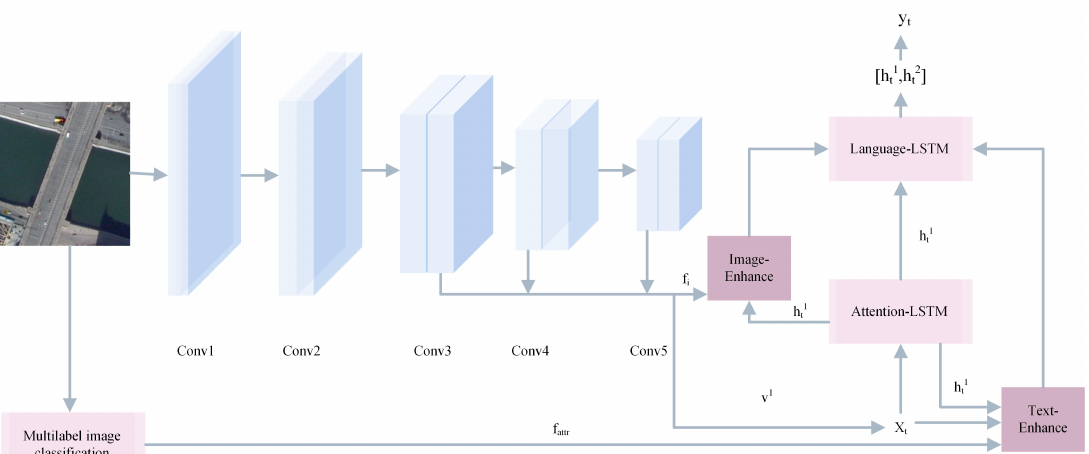
Figure 1. Overview of the proposed method—DFEN. The duality of DFEN is most visible in the visual feature of image acquisition and text information enhancement. The Image-Enhance module, in particular, captures global image context features using multiscale image features and the hidden state. The Text-Enhance module captures the image potential ground objects using the multi-label image classification module to achieve text information